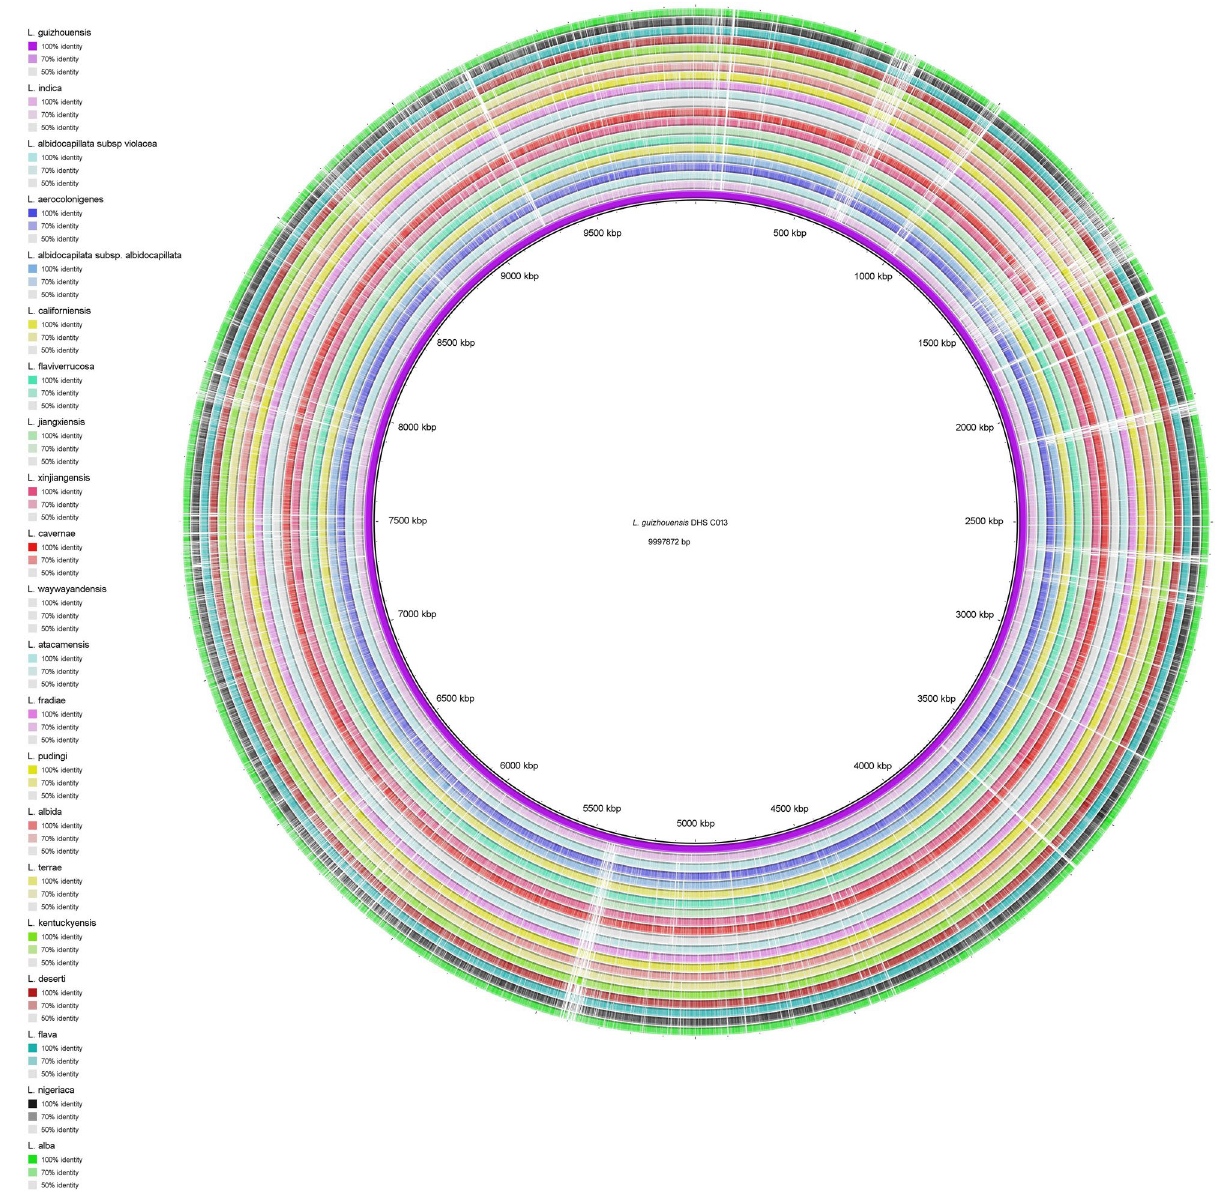
Figure 3. Circular map of the complete genome of L. guizhouensis DHS C013 along with the comparative genome maps of rest of the available Lentzea genome sequences. The figure was designed using BRIG 25 . The gaps in the circles represent regions of low or no